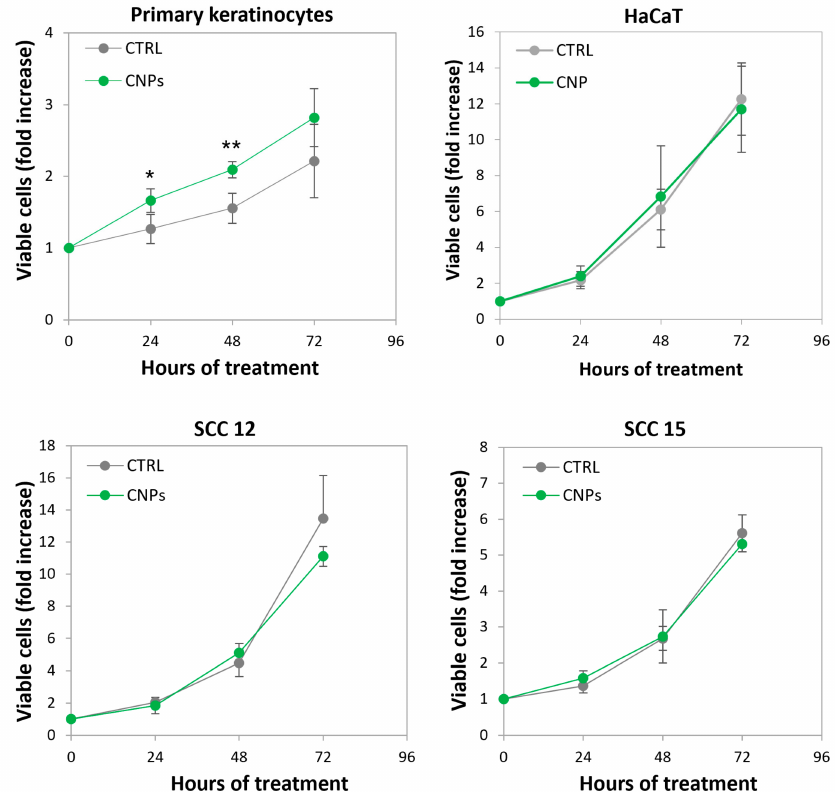
Figure 7. Nanoceria favour the proliferation of normal keratinocytes but not of HaCaT or squamous cell carcinoma keratinocytes. Nanoceria (CNPs) were administered at day 0 to primary keratinocytes, HaCaT, and two squamous cell carcinoma keratinocytes cell lines (SCC 12 and SCC 15). Kinetics of viable (trypan blue excluding) cell number expressed as fold over day 0. Statistical significance was calculated via Student’s t -test. * p < 0.05, ** p < 0.01 with respect to untreated